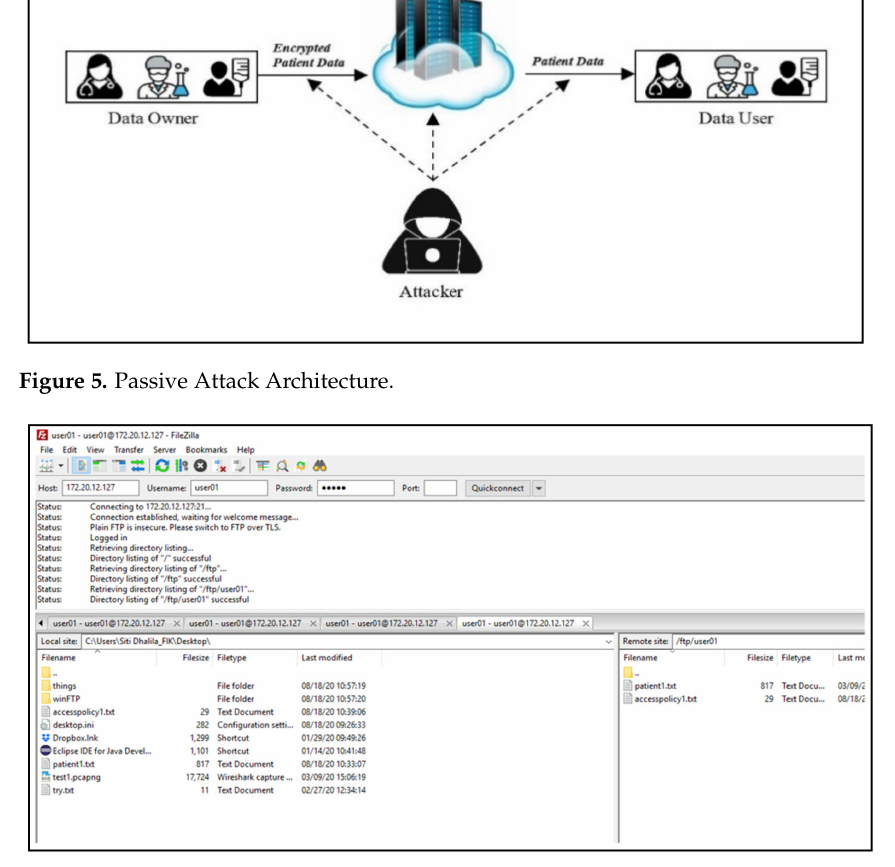
Figure 6. Filezilla